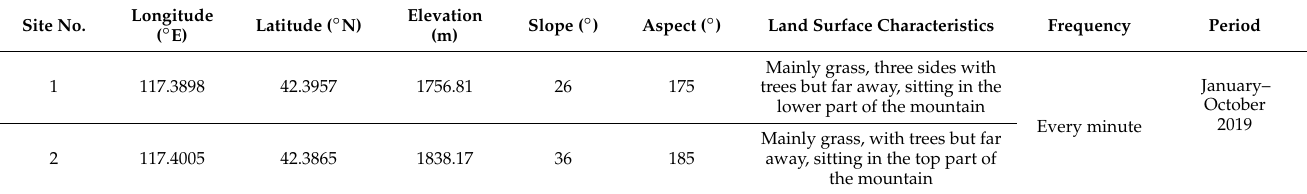
Table 2. Characteristics of the two SFP sites used in this